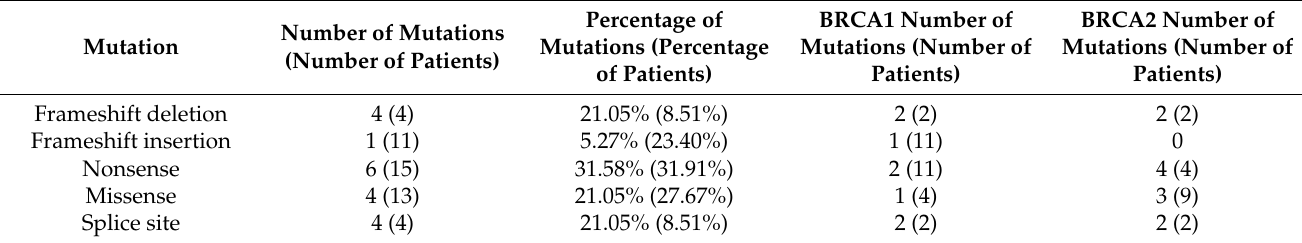
Table 3. BRCA1/2 mutations in the BC patient